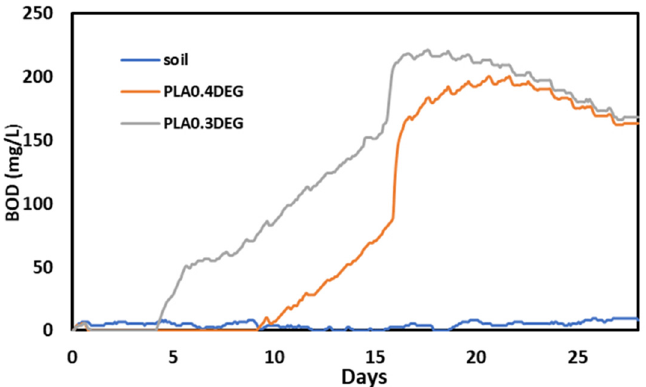
Figure 6. Results of biochemical oxygen demand of eco-polyols during 28 days in soil.